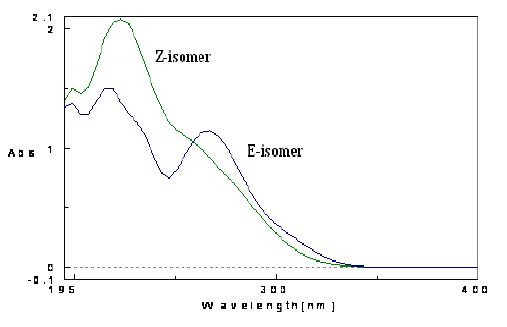
Figure 1. UV absorption spectra of compounds ( Z )- 1a and ( E )- 1a .